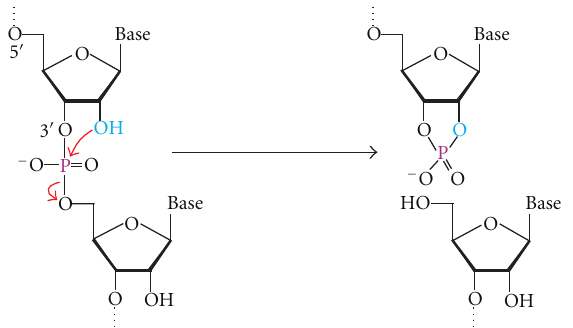
Figure 1: The chemical reaction catalyzed by RNase DNAzymes. These DNAzymes cleave a phosphodiester bond using the 2 (cid:2) - hydroxyl (light blue) as the